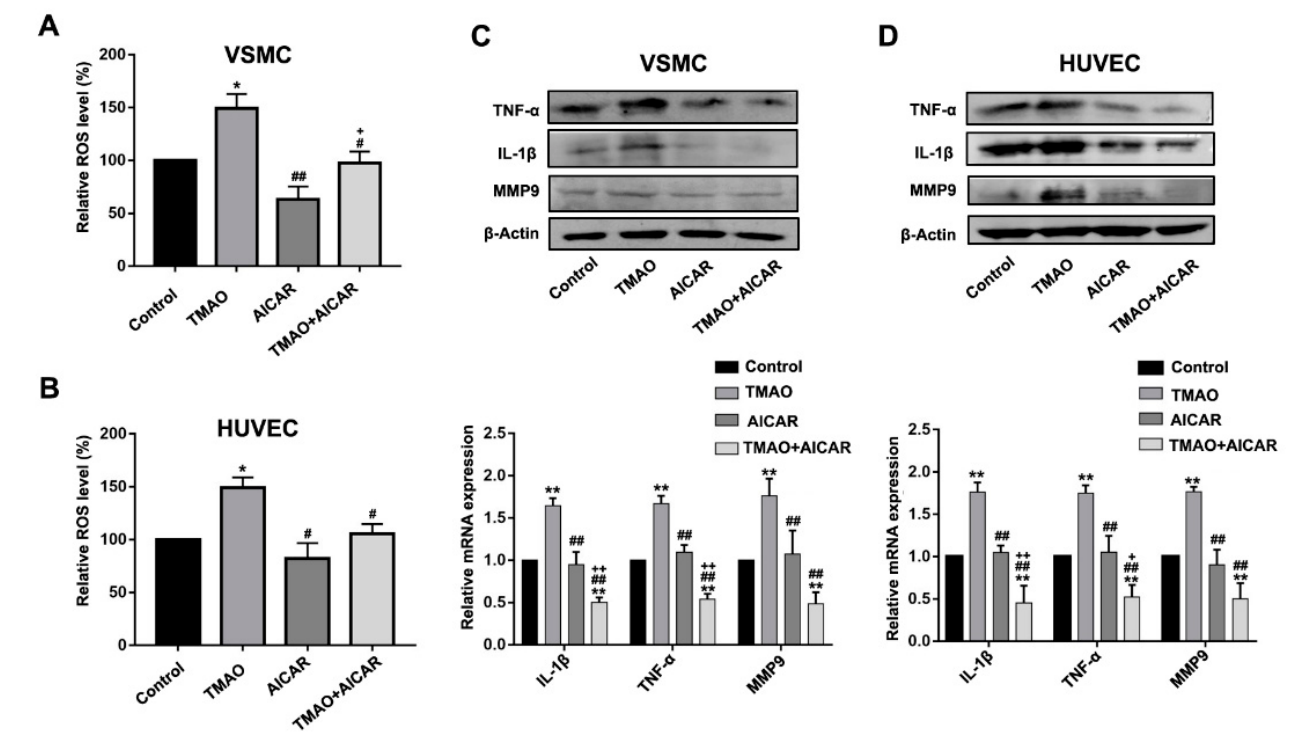
Figure 4. TMAO increased the ROS level and inflammatory factors by inhibiting AMPK levels in VSMCs and HUVECs. ( A , B ) The total ROS levels were determined after 1000 μ M TMAO, 5 mM AICAR and 1000 μ M TMAO plus 5 mM AICAR treatment for 24 h using fluorescence intensity of DCFH ‐ DA staining by flow cytometry in VSMCs ( A ) and HUVECs ( B ).( C , D ) The protein level (up ‐ per panels) and relative mRNA level (lower panels) of TNF α ,IL ‐ 1 β and MMP9 were detected by western blot and real ‐ time PCR in VSMCs ( C ) and HUVECs ( D ). Values are the mean ± SD; n = 3; two ‐ way ANOVA followed by a Tukey post hoc test. * p < 0.05; ** p < 0.01 vs. Control; # p < 0.05; ## p < 0.01 vs. TMAO group; + p < 0.05; ++ p < 0.01 vs. the AICAR group.